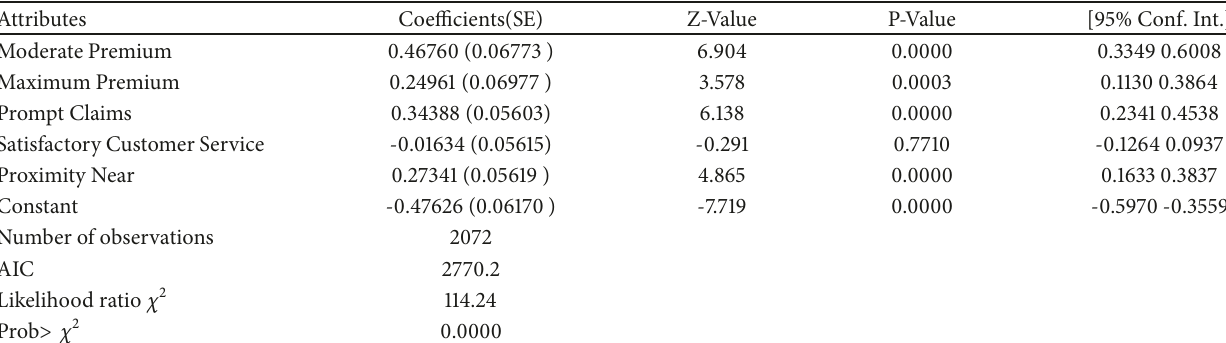
Table 7: Parameter estimates of model based on female